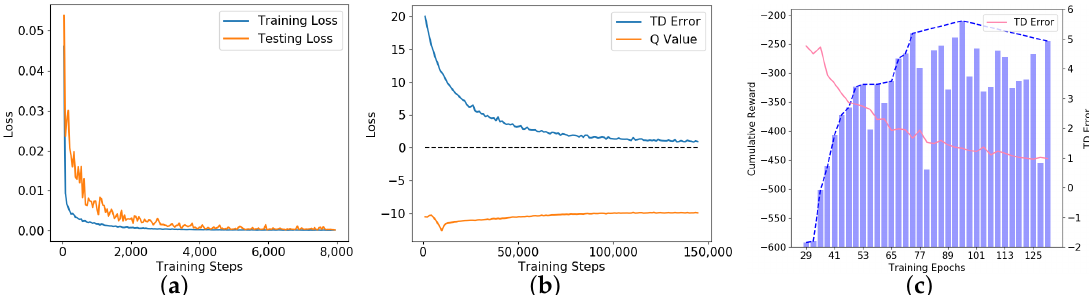
Figure 11. The performance of the DDPG model in the virtual environment. ( a ) shows the loss curve of the actor network pre-training, the blue line represents the training loss curve while the orange line represents the testing loss curve. ( b ) shows the loss curve of the DDPG model training, the blue line represents the TD error while the orange line represents the Q value. ( c ) shows the relationship between the TD error (red line) and the average cumulative reward (blue bar).